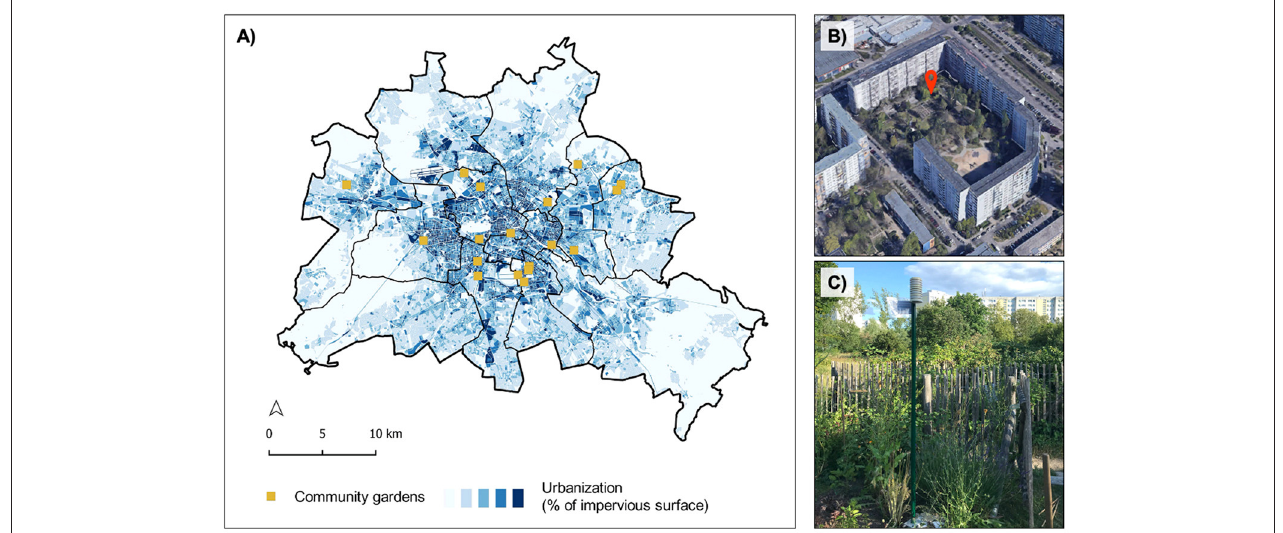
FIGURE 1 | Study system in the metropolitan region of Berlin, Germany where the 18 community gardens examined (yellow squares) and along an urbanization (% impervious surface) gradient (A) ; an inset of a garden surrounded by residential housing structures [ (B) ; Photo: Google Inc (2021)]. Photo of the temperature station in a garden in Marzahn, Germany [ (C) ; Photo: M